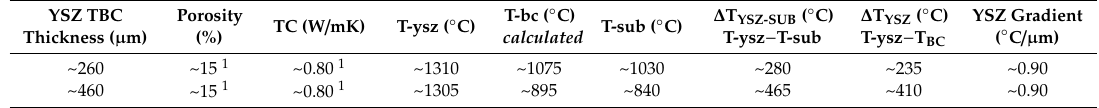
Table 2. Porosity, TC, thermal gradient temperatures, temperature drops and gradients of newly manufactured and optimized porous APS YSZ TBCs, operating within the acceptable